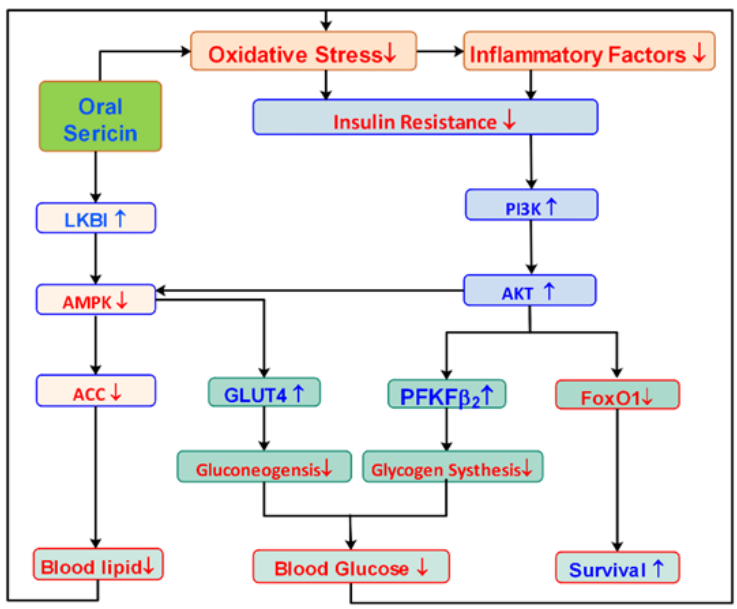
Figure 5. Possible pathways through which oral sericin might affect T2D rats. ↓ & ↑ , means upstream and downstream of the pathway and feedback regulation, respectively.